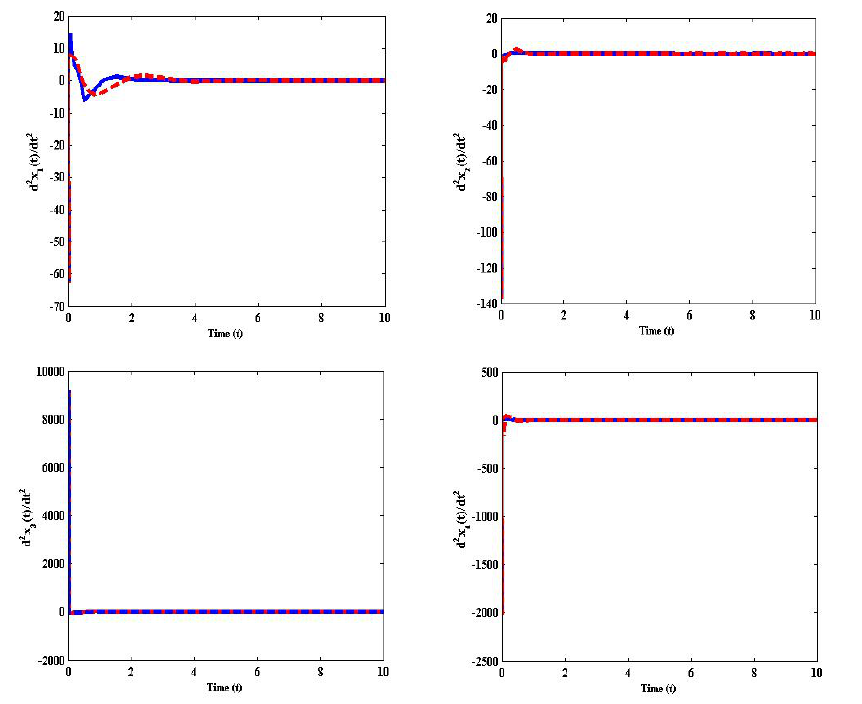
Figure 3. Acceleration trajectories of controlled and uncontrolled for nominal system (22).